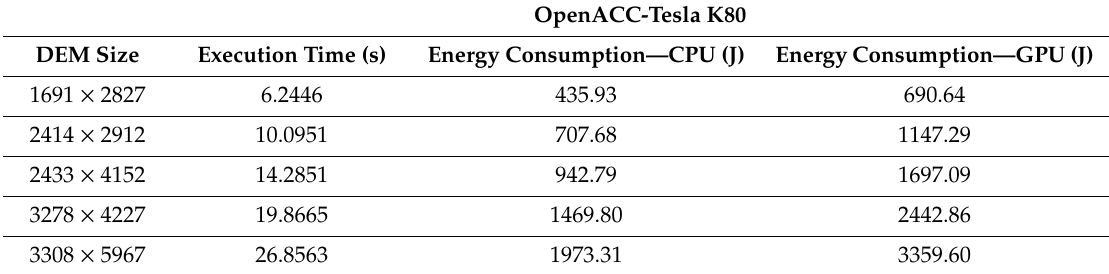
Table 7. OpenACC-Tesla K80.